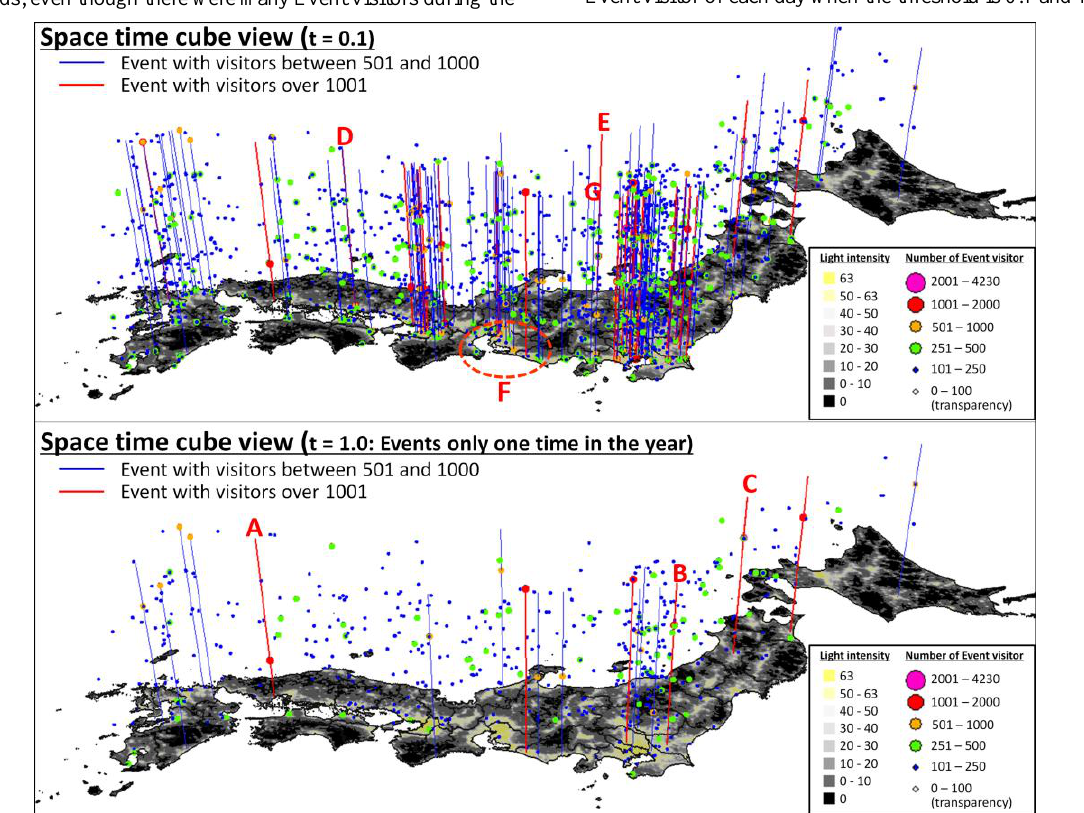
Figure 16. Space time cubes which shows Event days when thresholds are 0.1 and 1.0 in